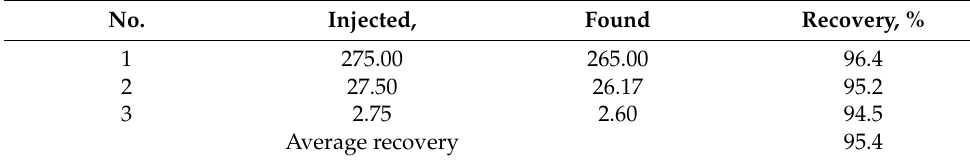
Table 2. The accuracy studies of the MIP-based MB microchip ( µ g/10 mL